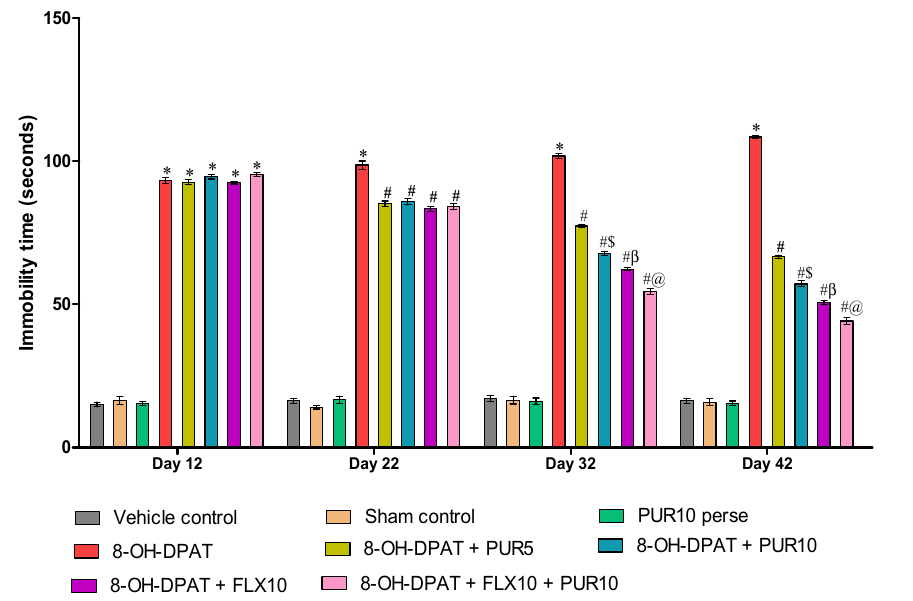
Figure 4. Effect of purmorphamine on immobility time in 8-OH OCD. Statistical analysis followed by two-way ANOVA (post-hoc Bonferroni’s test). Values expressed as mean ± SEM ( n = 6 rats per group). * p < 0.01 v/s vehicle control, sham control and PUR10 per se; # p < 0.01 v/s 8-OH-DPAT; #$ p < 0.01 v/s 8-OH-DPAT + PUR5; # β p < 0.01 v/s 8-OH-DPAT + PUR5 and 8-OH-DPAT + PUR10;